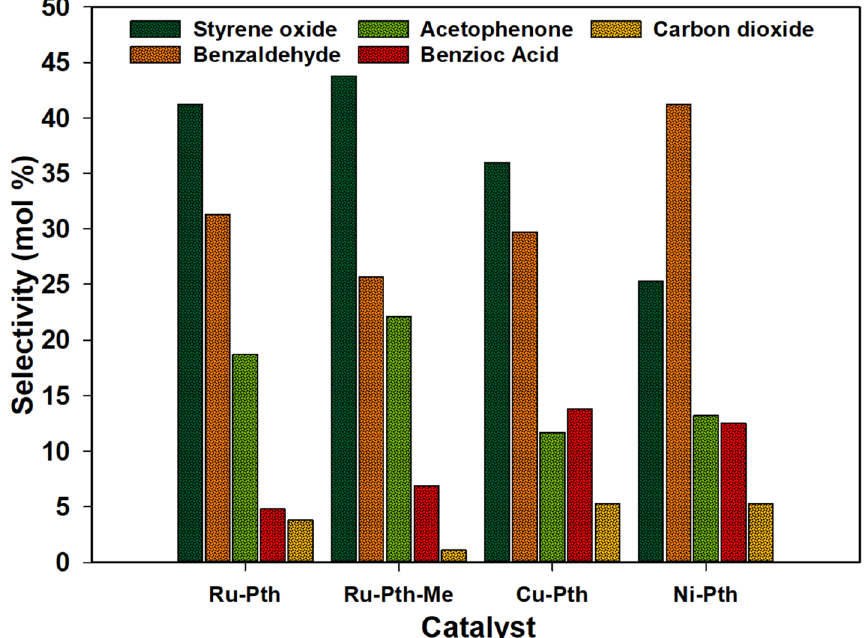
Figure 8. Selectivity towards products in the oxidation of styrene over various complexes under conditions: catalyst: styrene (1:100); styrene : H 2 O 2 (1:1); solvent: acetonitrile; temperature: 60 °C.